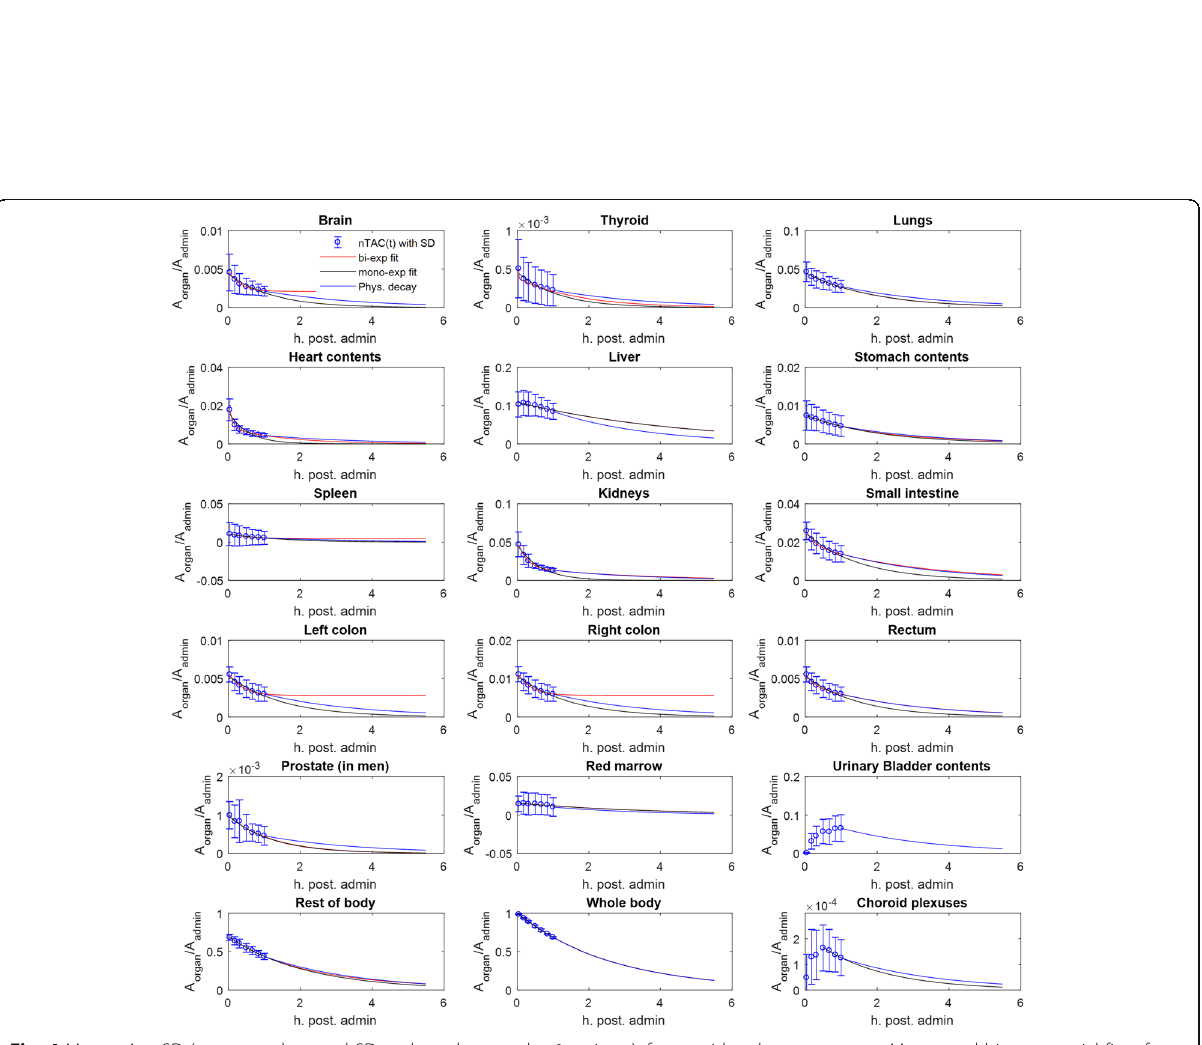
Fig. 4 Mean nA ± SD (average values and SD evaluated across the 6 patients), for considered source organs. Mono- and bi-exponential fits of experimental data are displayed in addition to the tail according to pure physical decay to infinity for t > 60 min. For sake of visibility, the time base in each source organ graph was restricted to three times the physical half-life of 18